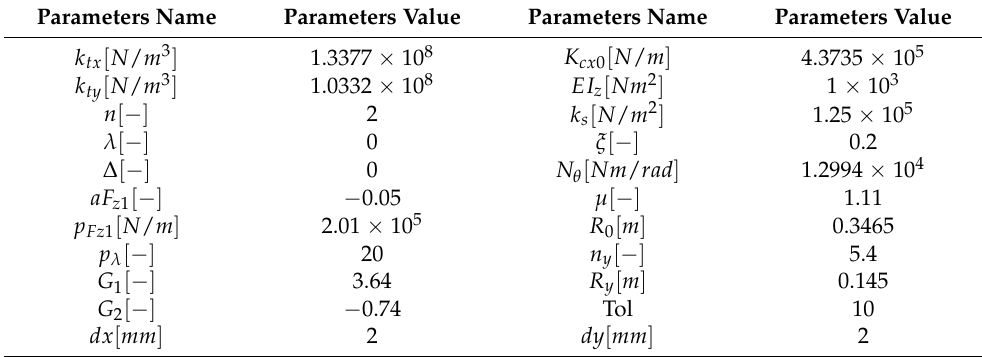
Table 2. The discrete tire model parameters.